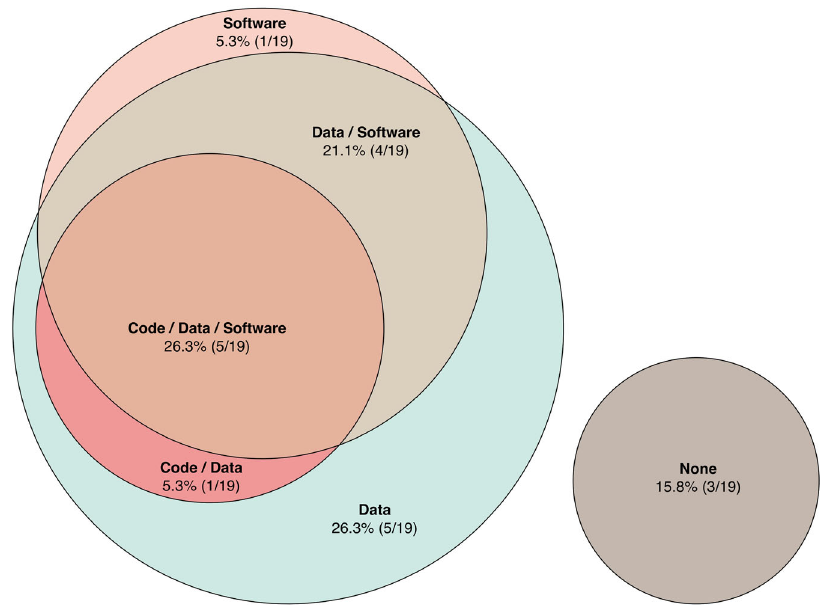
Fig. 2 Open science practices in machine learning for antibiotic discovery. This Euler diagram visualizes public release rates for source code, training or testing data, software, and combinations thereof among publications cited in this review (Table 2). Note that data release criteria for this analysis include both partial and full public availability. This analysis was performed post hoc on studies previously cited in this